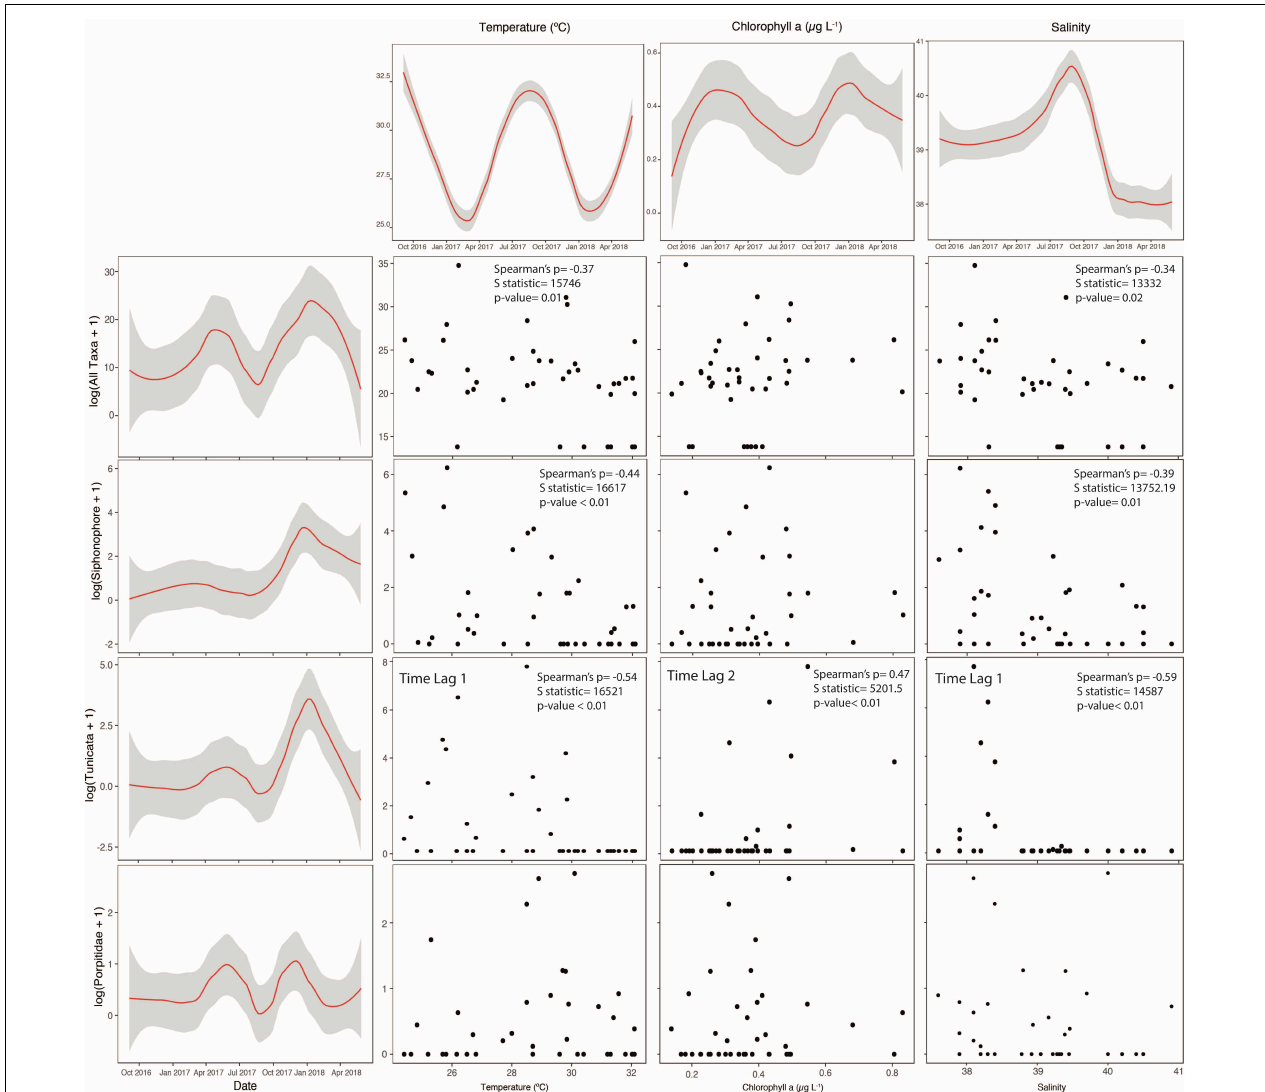
FIGURE 3 | Correlation plots between environmental drivers over time (first row) and taxa occurrence over time (first column; biovolume). Spearman’s rank test results are shown where test resulted significant. Temporal interpolation was performed with loess (span = 0.45) and 95% confidence intervals.